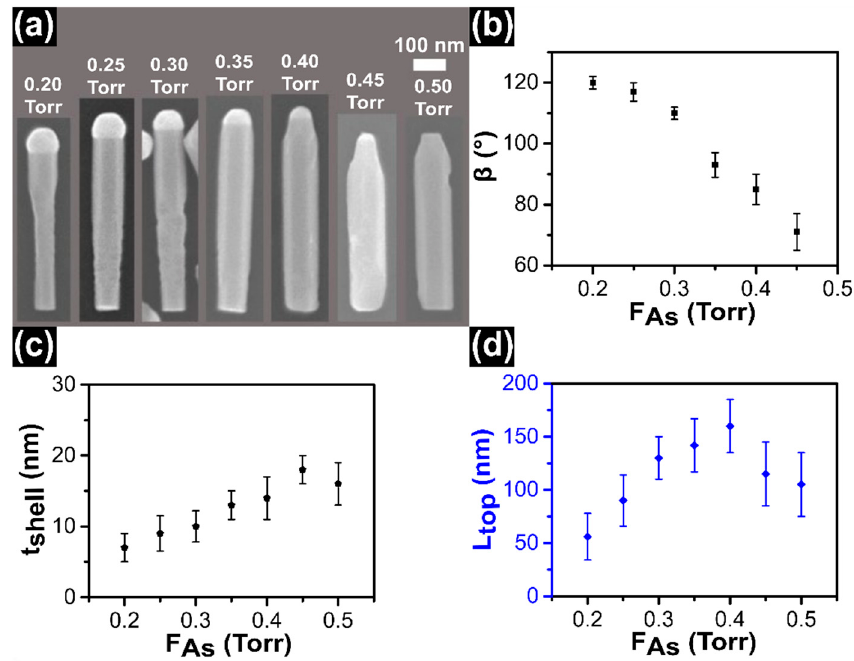
Figure 2. ( a ) SEM images of InSb/InAs QD NWs obtained with fixed line pressures F In = 0.30 Torr, growth time 15 min and T InAs = 440 ± 5 °C, while F As varied from 0.20 Torr to 0.50 Torr as indicated in each panel. The droplet volume decreases with increasing F As and finally there is no droplet in the sample grown with F As = 0.50 Torr. ( b ) Plot of contact angle ( β ) of In droplets versus F As . ( c ) Evolution of shell thickness around the InSb QD versus F As . ( d ) Evolution of length of top InAs segments ( L top ) as a function of F As . The symbols represent an average value of each sample obtained by measuring ~25 NWs and error bars represent the standard deviation of the